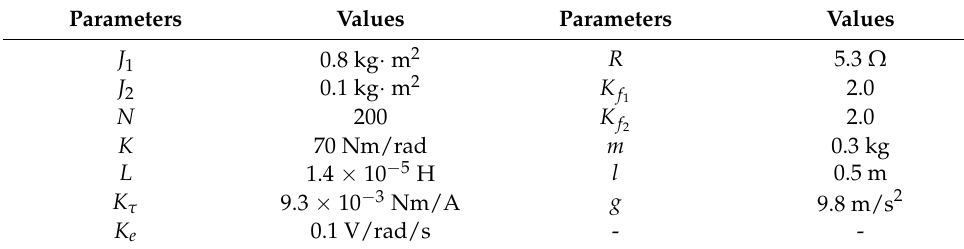
Table 1. The simulation model parameters of single-link FJ robot.